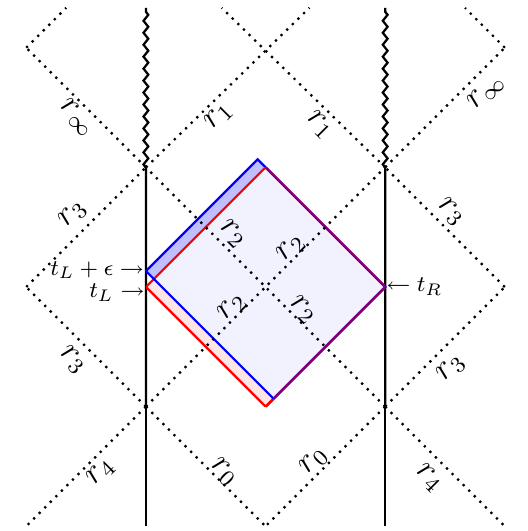
Fig. 2 Penrose diagram for a charged two sided black hole with mul- tiple horizons and WDW patch in late time approximation. r 1 is the most internal horizon and r 0 is the null spatial infinity. The wavy lines indicate the singularities at r = 0, and r ∞ stands for r =